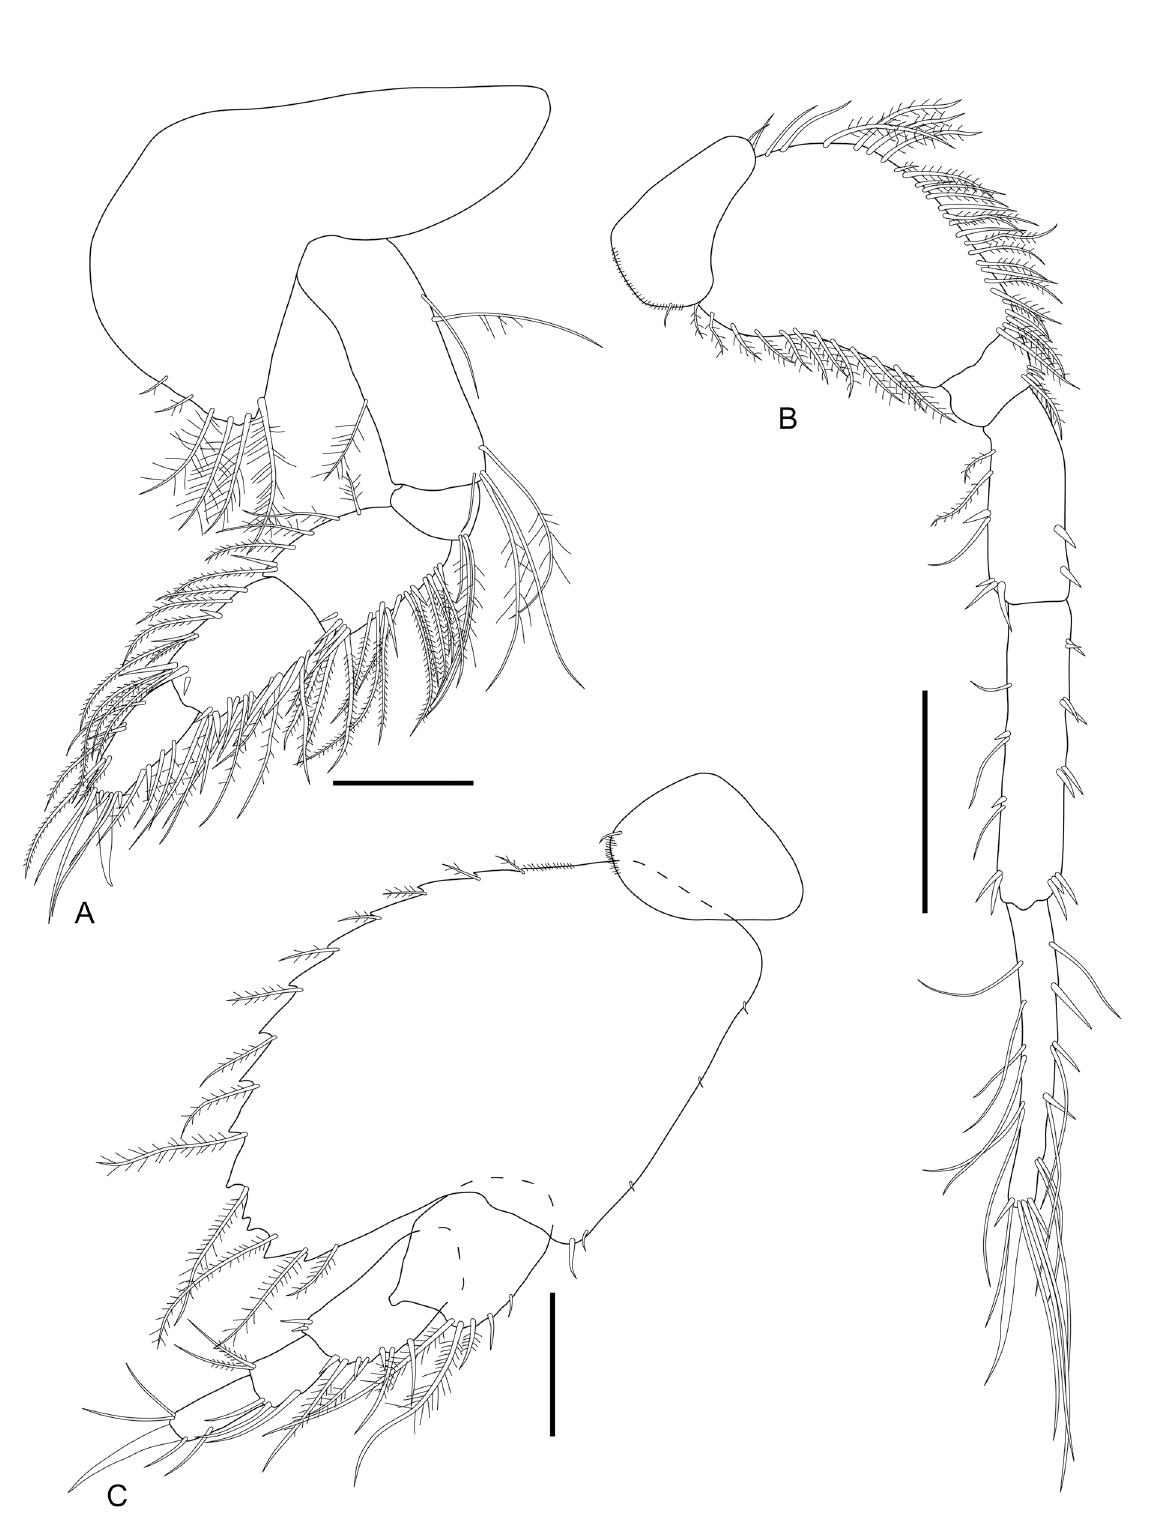
Fig. 4. Heterophoxus shoemakeri sp. nov., holotype, ♀ (UERJ 433). A . Pereopod 5. B . Pereopod 6. C . Pereopod 7. Scale bars = 0.2